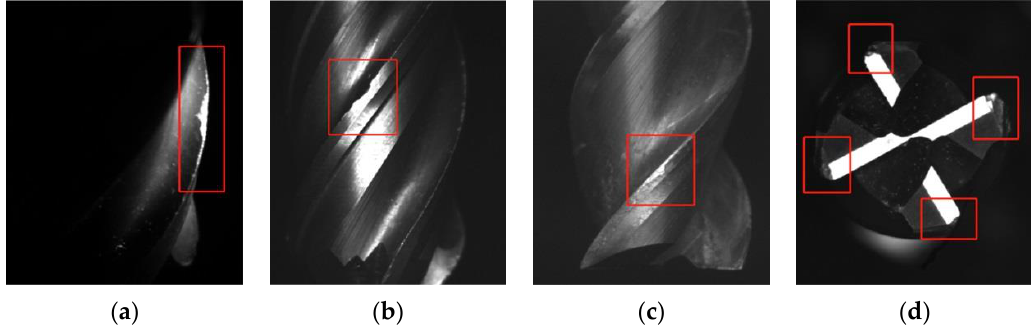
Figure 1. Photos of typical failure forms of integral spiral end milling cutter: ( a ) Crater wear; ( b ) Flank wear; ( c ) Edge chipping; ( d ) Tool tip breakage.